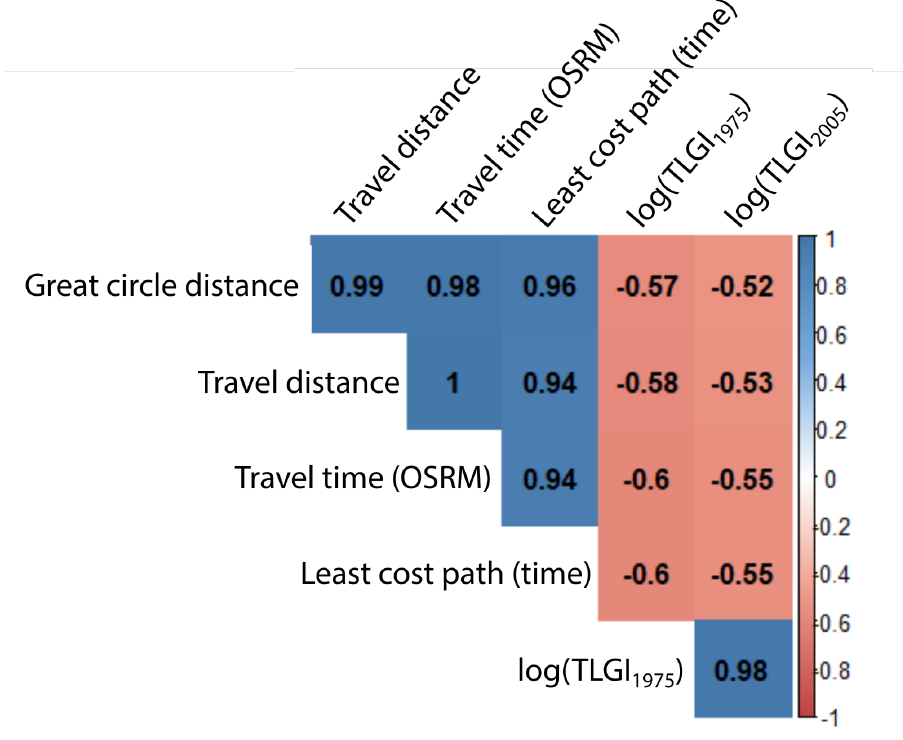
Figure 10. Correlation crossplot of the distance-based explanatory